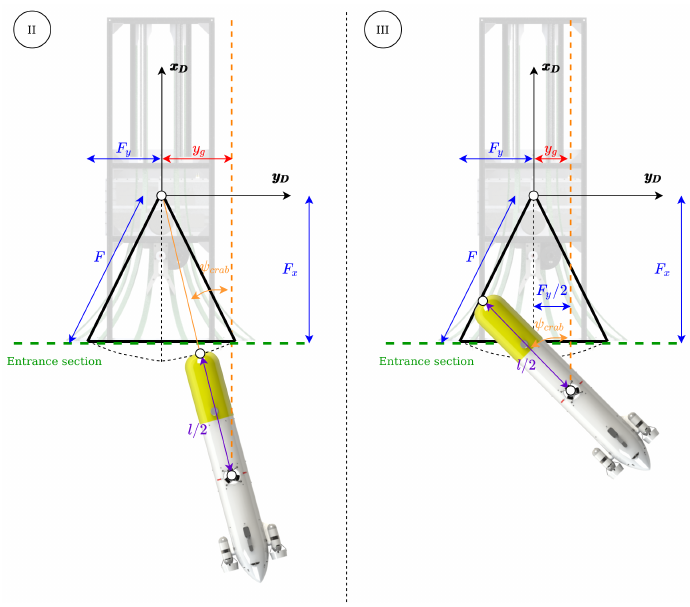
Figure 7. Gap calculus